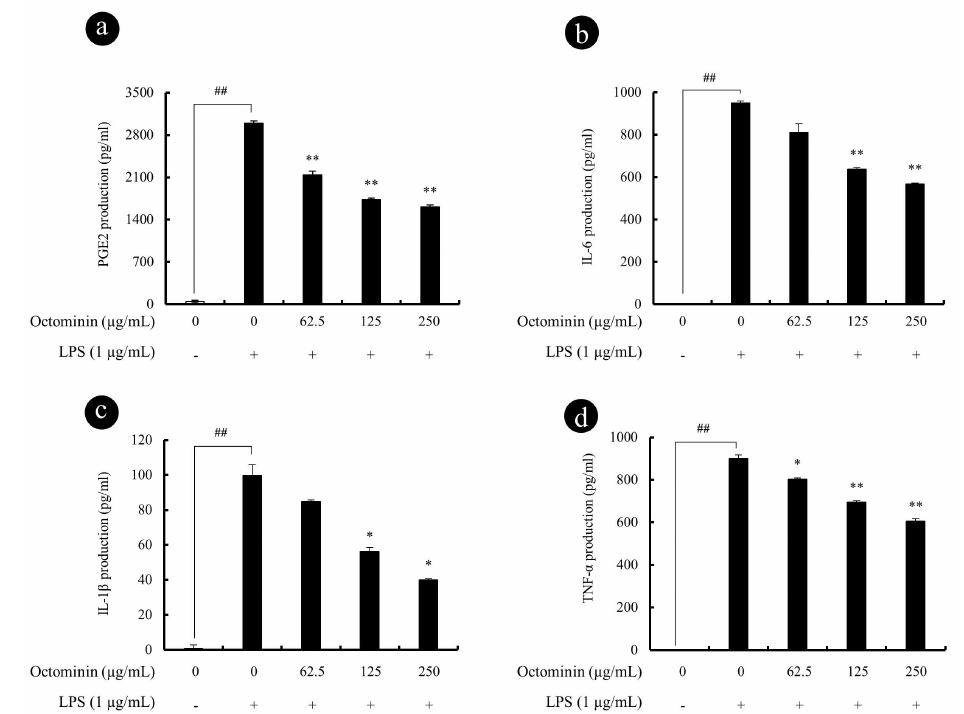
Figure 3. Octominin repress LPS-induced PGE2 and pro-inflammatory cytokine secretion from RAW 264.7 macrophages. Macrophages were exposed to Octominin for 1 h prior to activation with LPS. Cells were incubated for 24 h, and then the cell-free culture supernatants were collected. PGE2 ( a ), IL-6 ( b ), IL-1 β ( c ), and TNF- α ( d ) levels in the culture mediums were determined using ELISA kits. Experiments were triplicated to evaluate the data, and the mean value is expressed as ± SD. Statistical significance was determined versus vehicle-treated control group ( # < 0.05 and ## < 0.01) or LPS-treated group (* < 0.05 and ** <